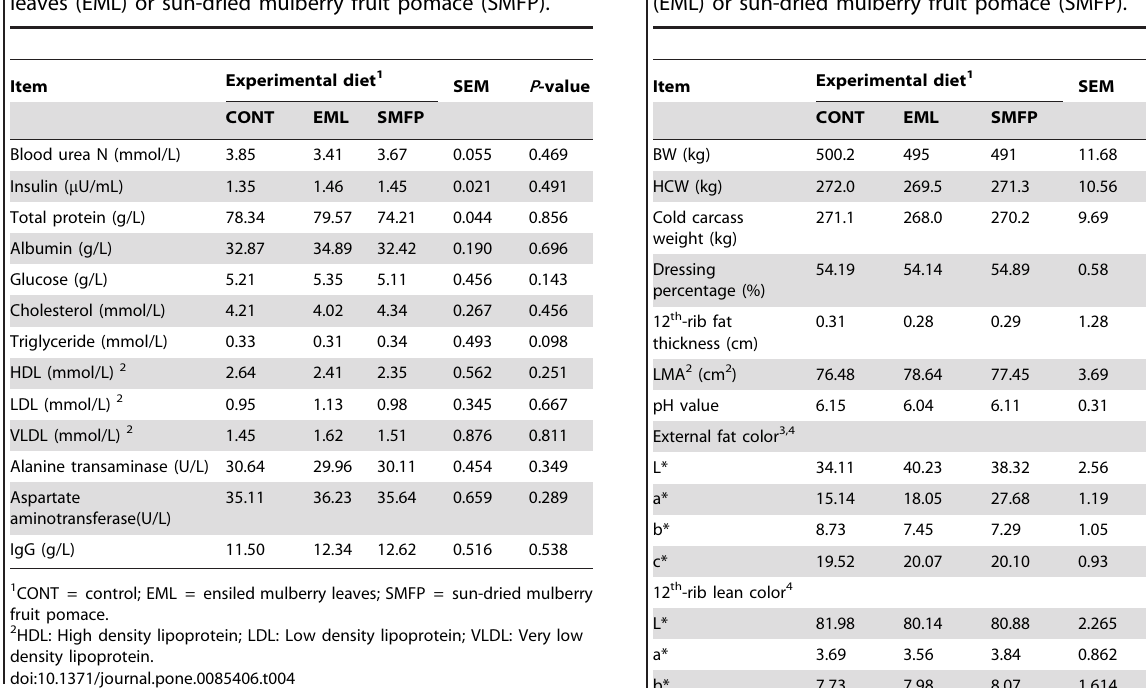
Table 4. Blood biochemical parameters of finishing steers fed a total mixed ration supplemented with ensiled mulberry leaves (EML) or sun-dried mulberry fruit pomace (SMFP).